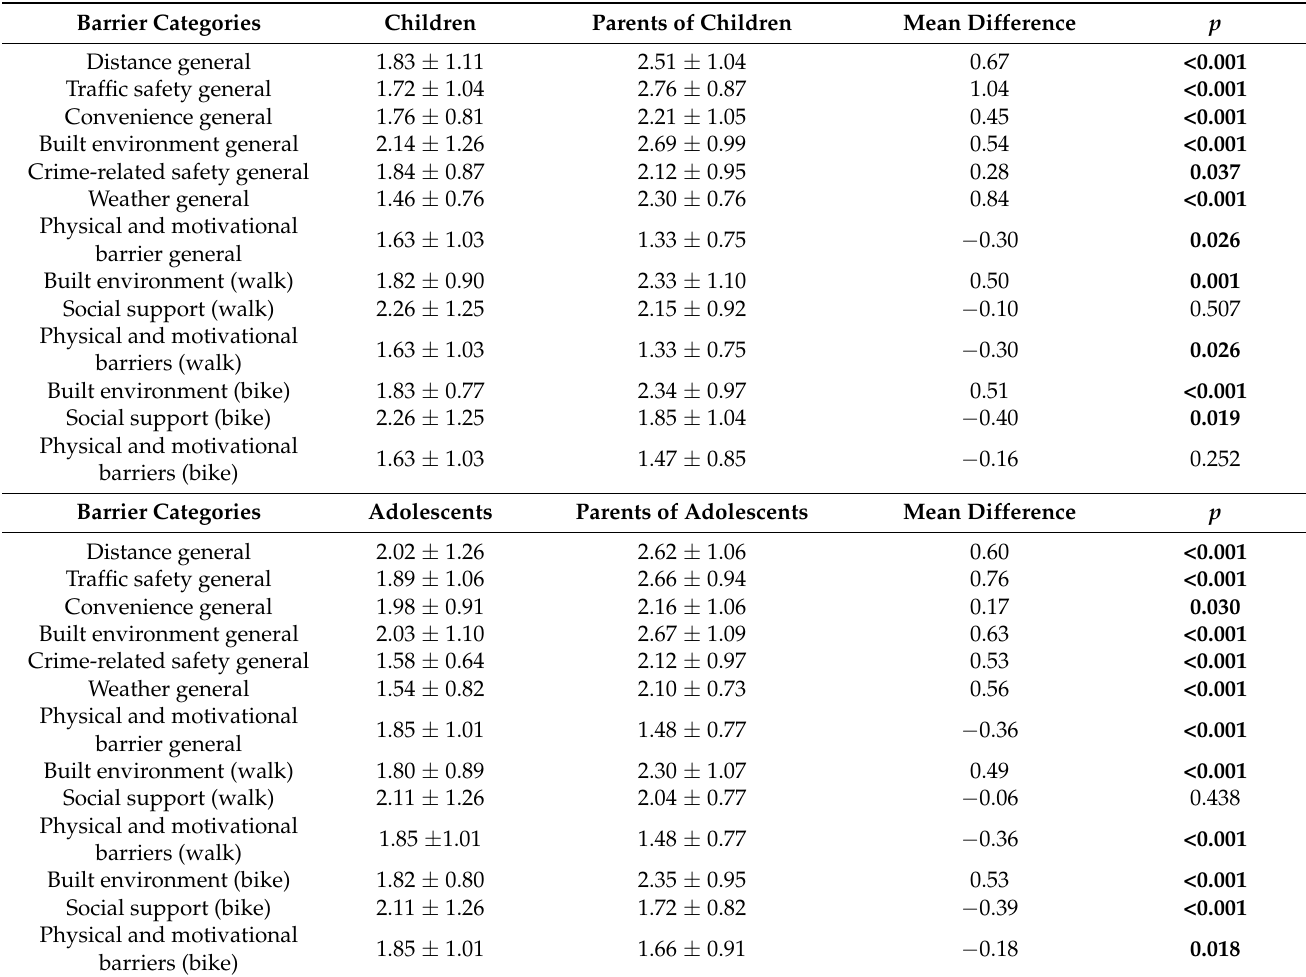
Table 3. Comparison of children’s and parents’ barriers for children and